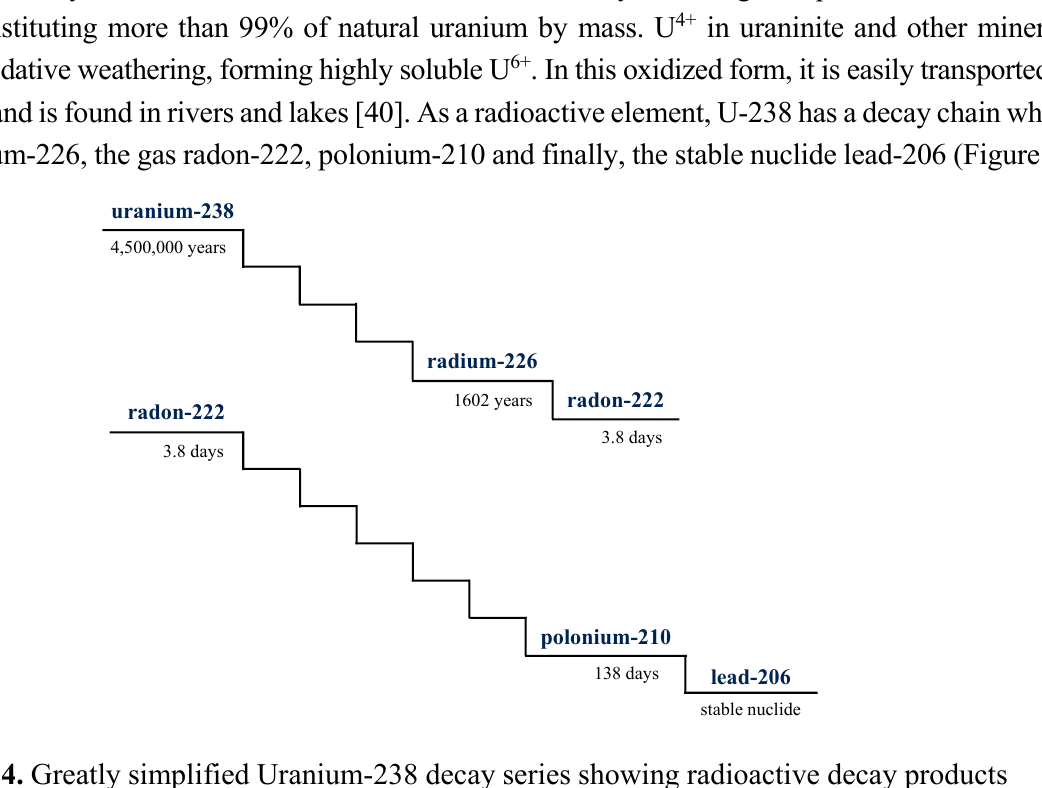
Figure 4. Greatly simplified Uranium-238 decay series showing radioactive decay products discussed in this report (adapted from